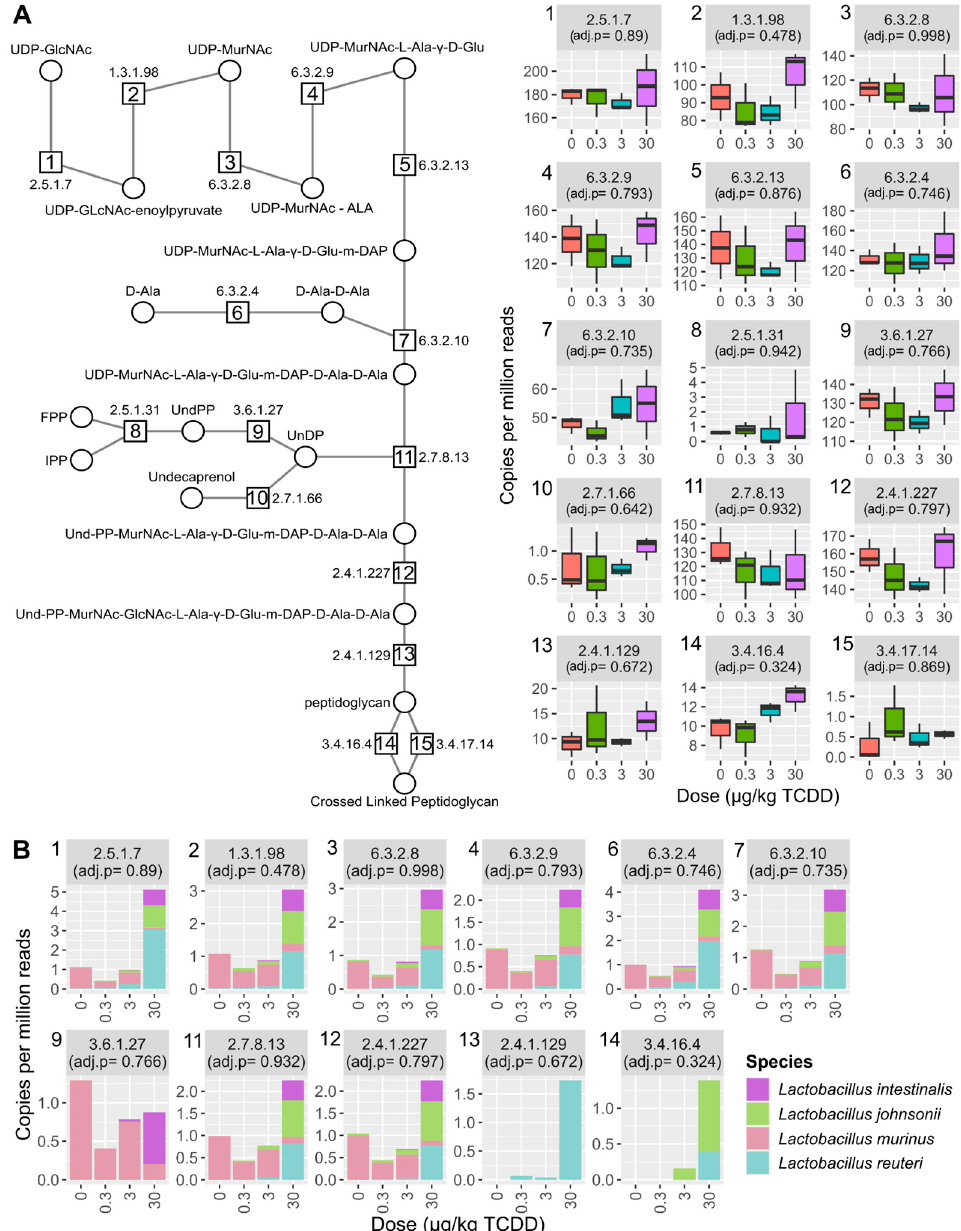
Figure 6. Peptidoglycan biosynthesis was unchanged by TCDD. ( A ) Relative abundance of peptidoglycan biosynthesis EC numbers identified in the metagenomic dataset. ( B ) Relative abundance of only Lactobacillus species classified to peptidoglycan biosynthesis EC numbers. Individual boxplots are numbered with the EC number matching the enzymatic step in pathway schematic. Adjusted p -values (adj. p ) were determined by MAASLIN2. Abbreviations: UDP-N-acetyl-alpha-D-glucosamine (UDP-GlcNac), UDP-N-acetylmuramate (UDP-MurNAc), UDP-N-acetyl-alpha-D-muramoyl-L- alanine (UDP-MurNAc-ALA), UDP-N-acetyl-alpha-D-muramoyl-L-alanyl-D-glutamate(UDP-MurNAc-Ala-D-Glu),